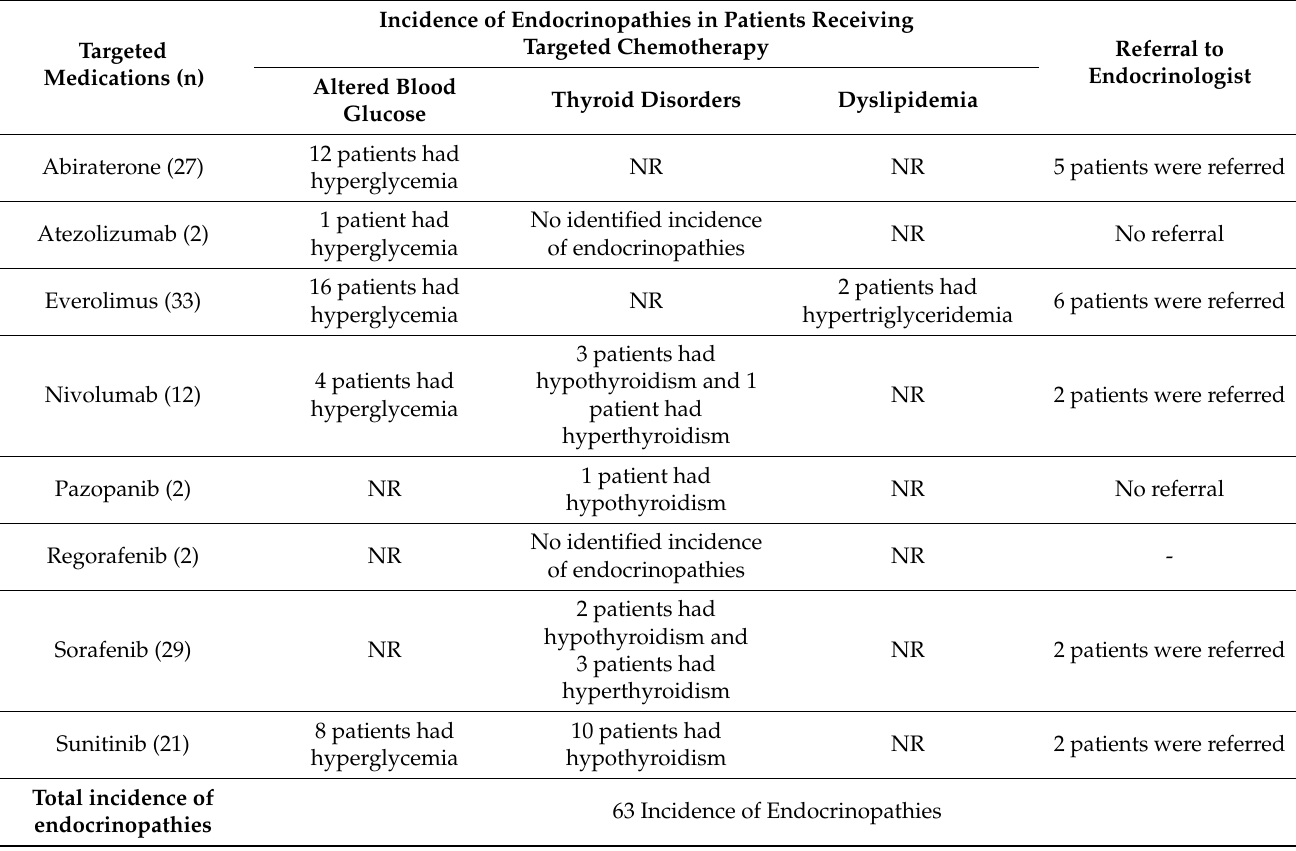
Table 4. Incidents and Types of Endocrinopathies in Patients Receiving Targeted